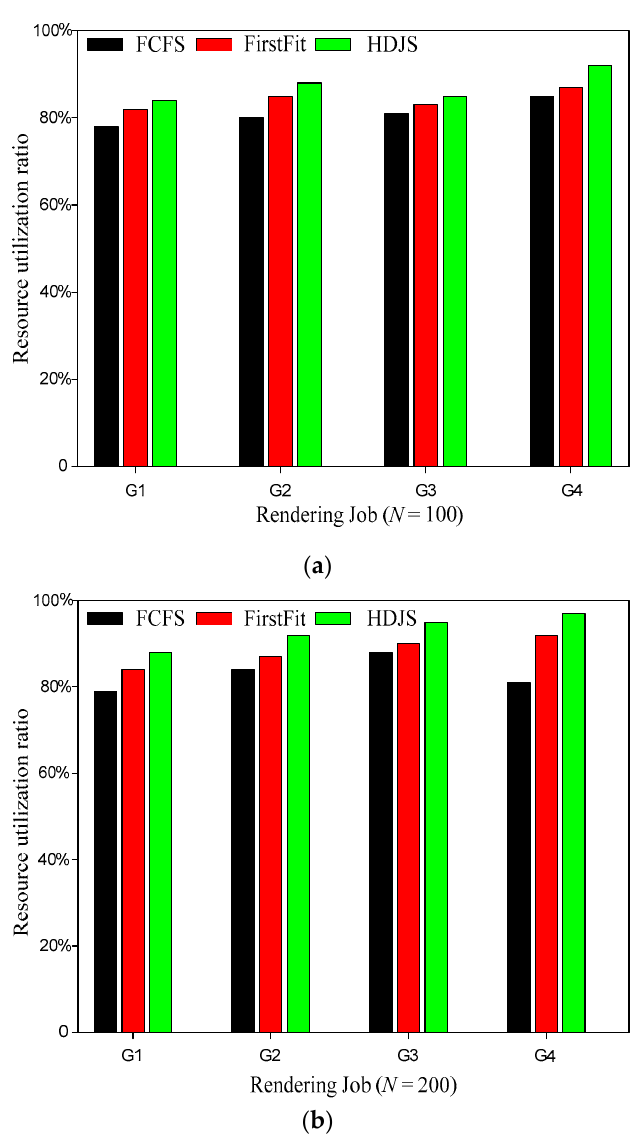
Figure 3. Comparison of resource utilization ratio for different strategies; ( a ) N = 100; ( b ) N = 200.